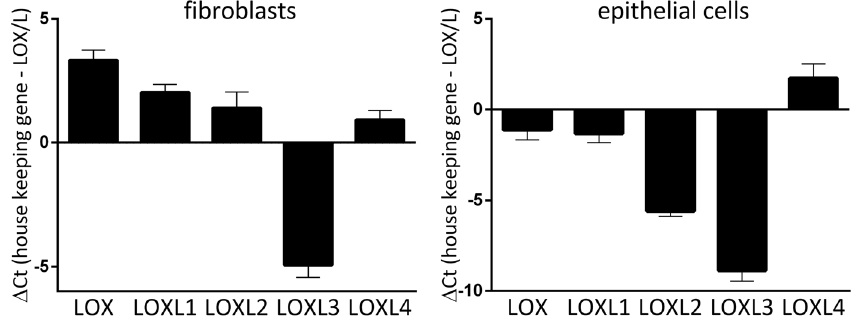
Figure 1. Basal expression levels of lysyl oxidases in primary human lung cells. LOX/L gene expression in primary human lung fibroblasts (NHLF) (left) or in air-liquid-differentiated primary bronchial epithelial cells (HBEC) (right) was determined using Taqman gene expression assays. Data is normalized to RNA-polymerase 2 expression (Ct value of 25) and presented as mean of Δ Ct ± SD of five independent